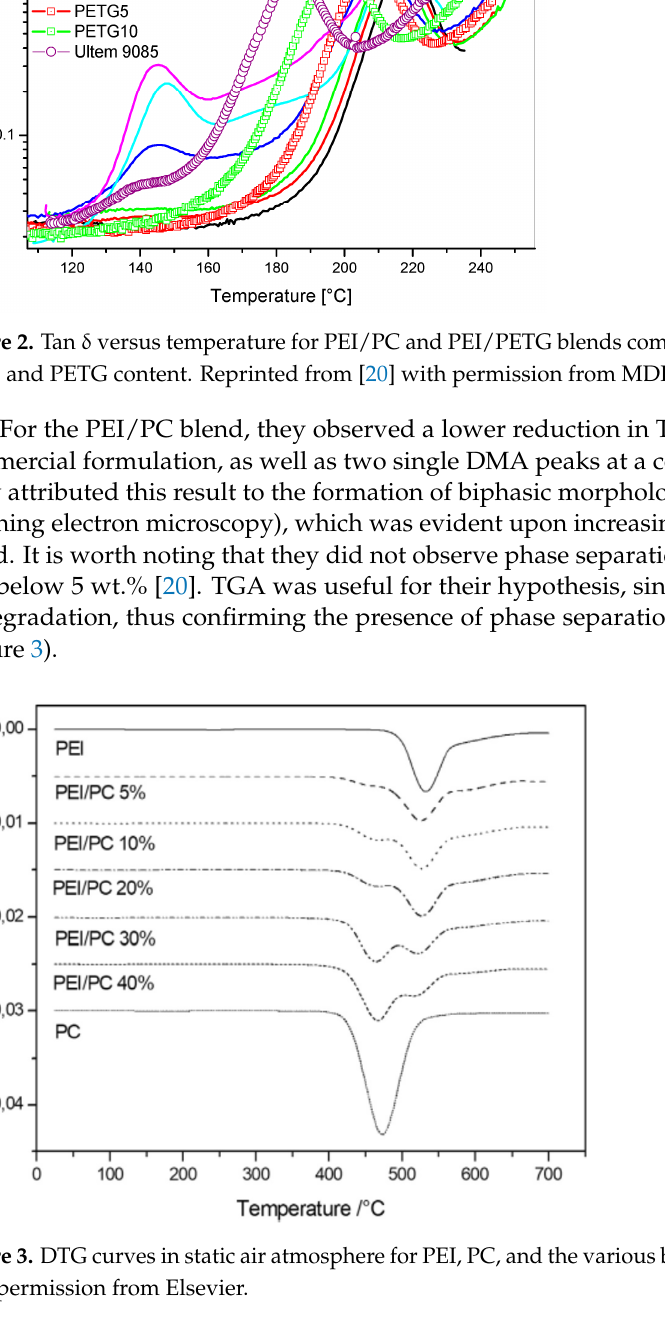
Figure 1. Specific heat of ( a ) binder and ( b ) feedstock during heating and cooling cycles derived from DSC results. Reprinted from [19] with permission from Elsevier.